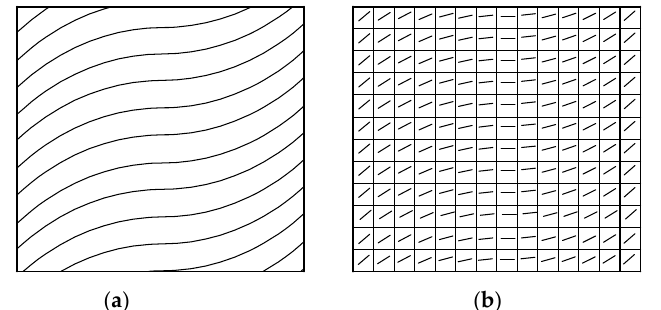
Figure 4. Schematic of the mesh after the variation angle layer has been divided: ( a ) Variable-angle layer, and ( b ) schematic diagram obtained after meshing.